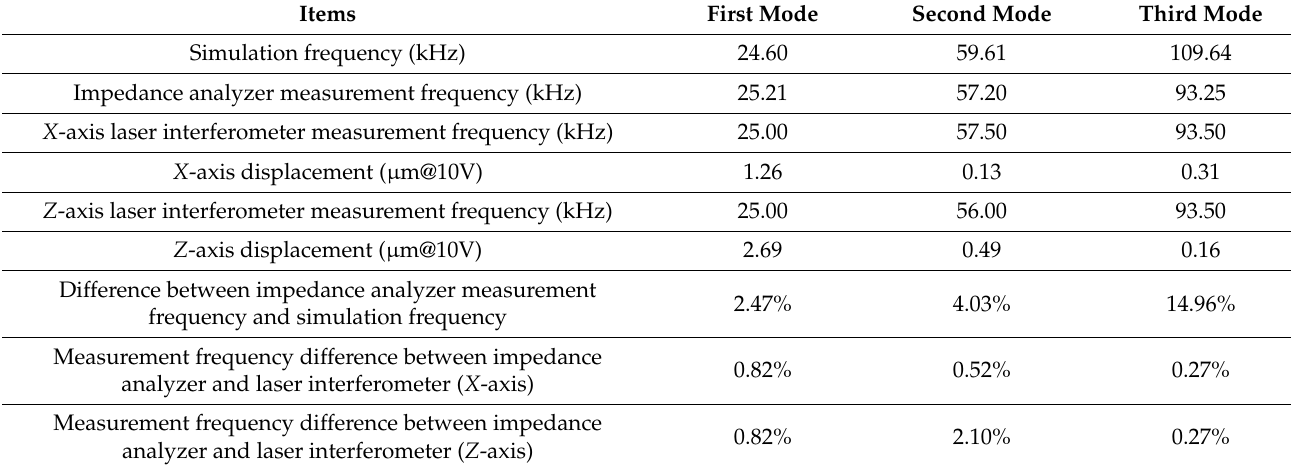
Table 1. Comparison between the simulation and measurement of the simple bimorph stator.